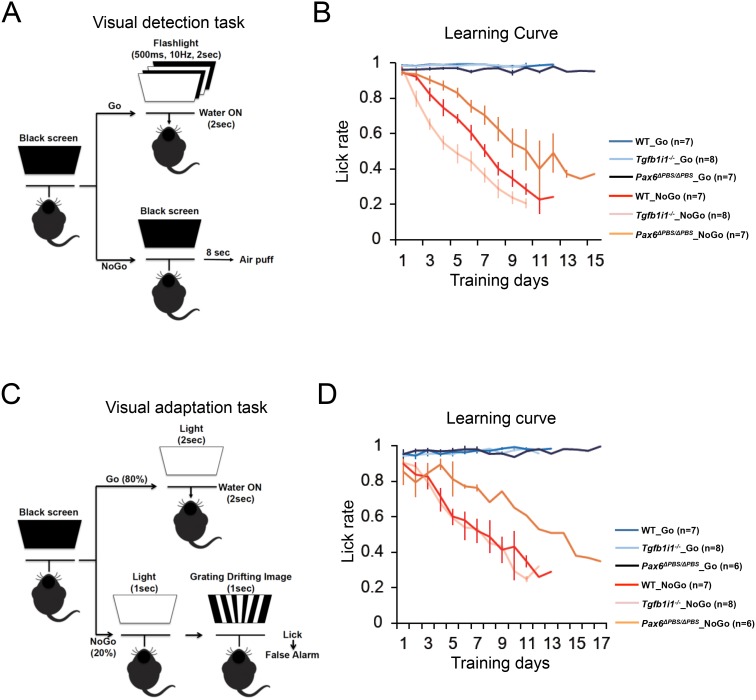
Experimental scheme assessing mouse visual responses.(A) P60 mice were trained to associate water rewards with flashing light stimuli. Correct and incorrect lick rates were used to measure visual detection. (B) Lick rates during the learning period for mice responding to various intensity of light as shown in Figure 4E. (C) P60 mice were trained to associate water rewards only with a continuous (2 s) light stimulus and not a continuous (1 s) light followed by a drifting grate image (1 s). Correct and incorrect lick rates were used to measure visual discrimination of the drifting grate from various intensities of light stimulus. (D) Lick rates during the learning period.